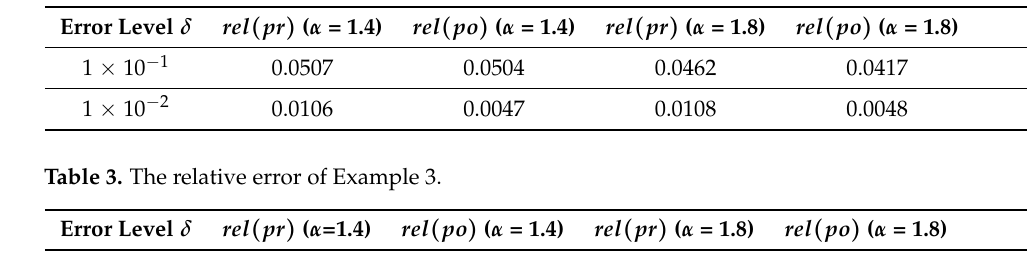
Table 2. The relative error of Example 2.